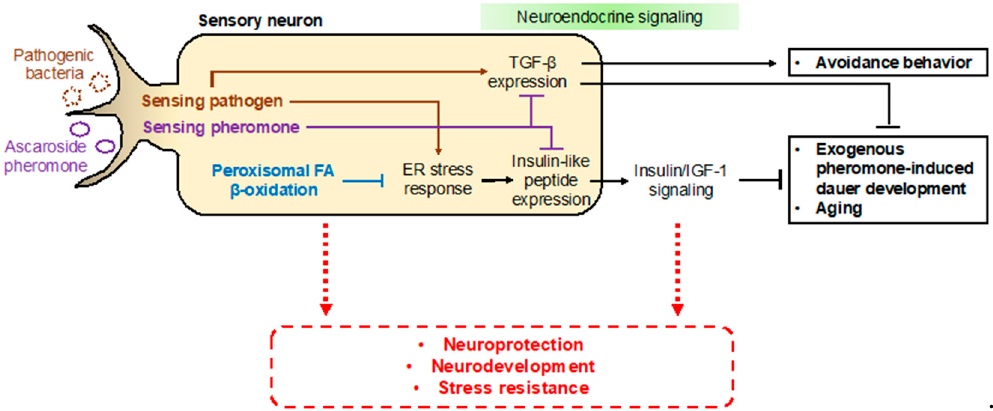
Figure 6. The protective ways in the sensory neurons and their outputs. In C. elegans , ascr pheromone sensing a ff ects the expression of neuropeptides, such as insulin and TGF- β . Peroxisomal fatty acid β -oxidation in sensory neurons regulates neuroendocrine signaling (e.g., insulin / IGF-1 signaling) via regulation of insulin-like peptide expression by suppressing the lipid-induced endoplasmic reticulum (ER) stress response. By regulating insulin / IGF-1 signaling, peroxisomal fatty β -oxidation controls both exogenous pheromone-induced dauer entry and aging. Furthermore, pathogens regulate TGF- β expression and ER stress via unfolded protein responses (UPRs). TGF- β expression triggered by pathogens stimulates avoidance behavior. Similarly, such signaling in the nervous system can influence neuroprotection, neurodevelopment, and stress resistance, either directly or via neuroendocrine signaling pathways.